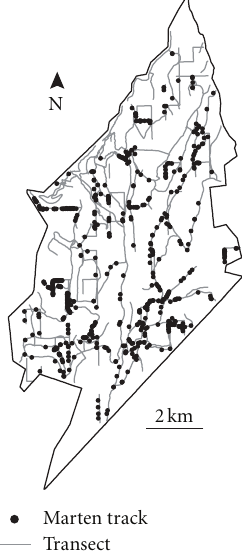
Figure 2: Transects sampled (lines) and marten tracks recorded (dots) in January–March 2008, at Montmorency Forest, Quebec, Canada (Projected Coordinate System: NAD83 NTM Zone